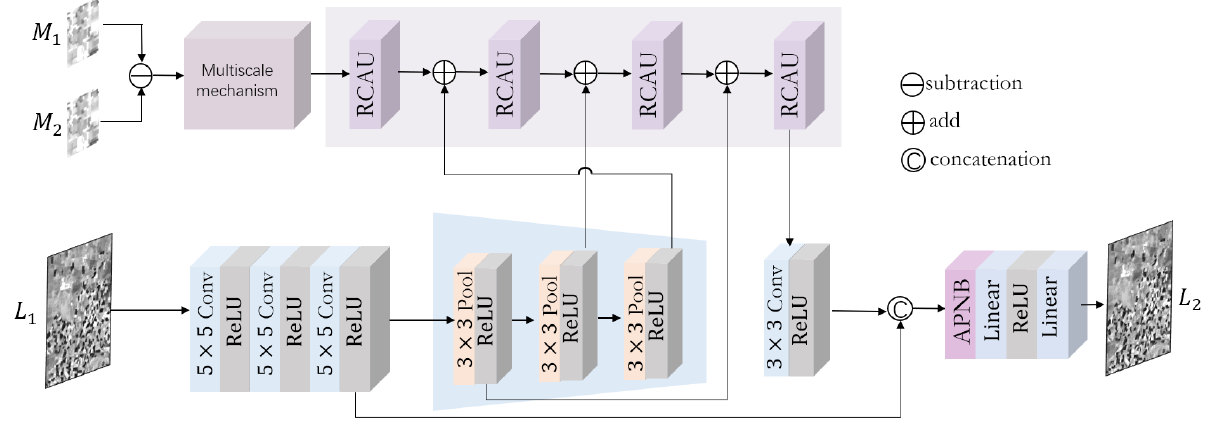
Figure 1. The overall architecture of